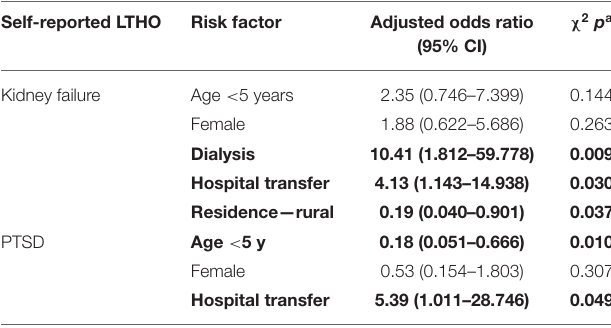
LTHO, long-term health outcome; CI, confidence interval; PTSD, posttraumatic stress disorder.